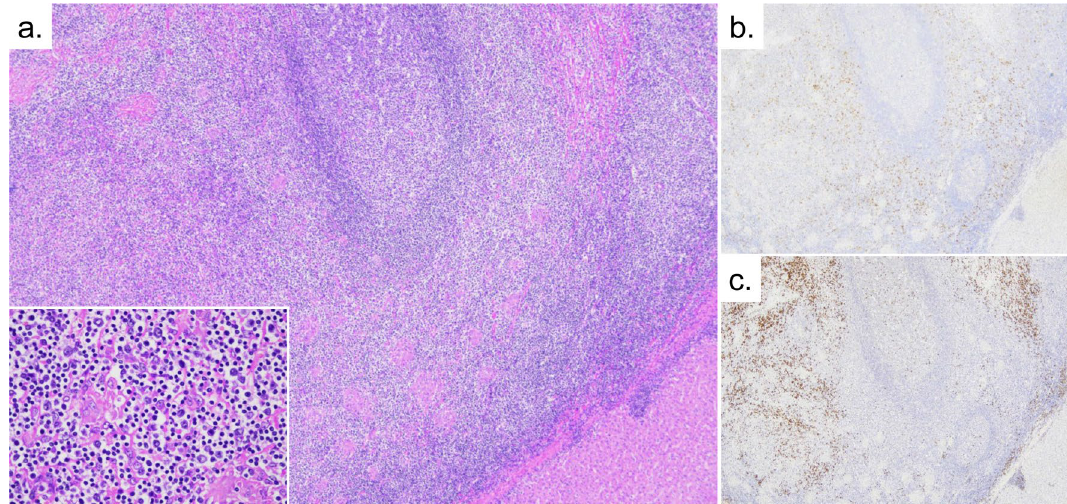
Fig. 3 Pathological findings of the resected specimen. Low-power view shows nodular lymphoplasmacytic proliferation containing lymph follicles, and the high-power view shows monocytoid B cell proliferation. a Hematoxylin and eosin staining (low and high-power view), b IRTA1 (FCRL4) (low-power view), c kappa chains (low-power